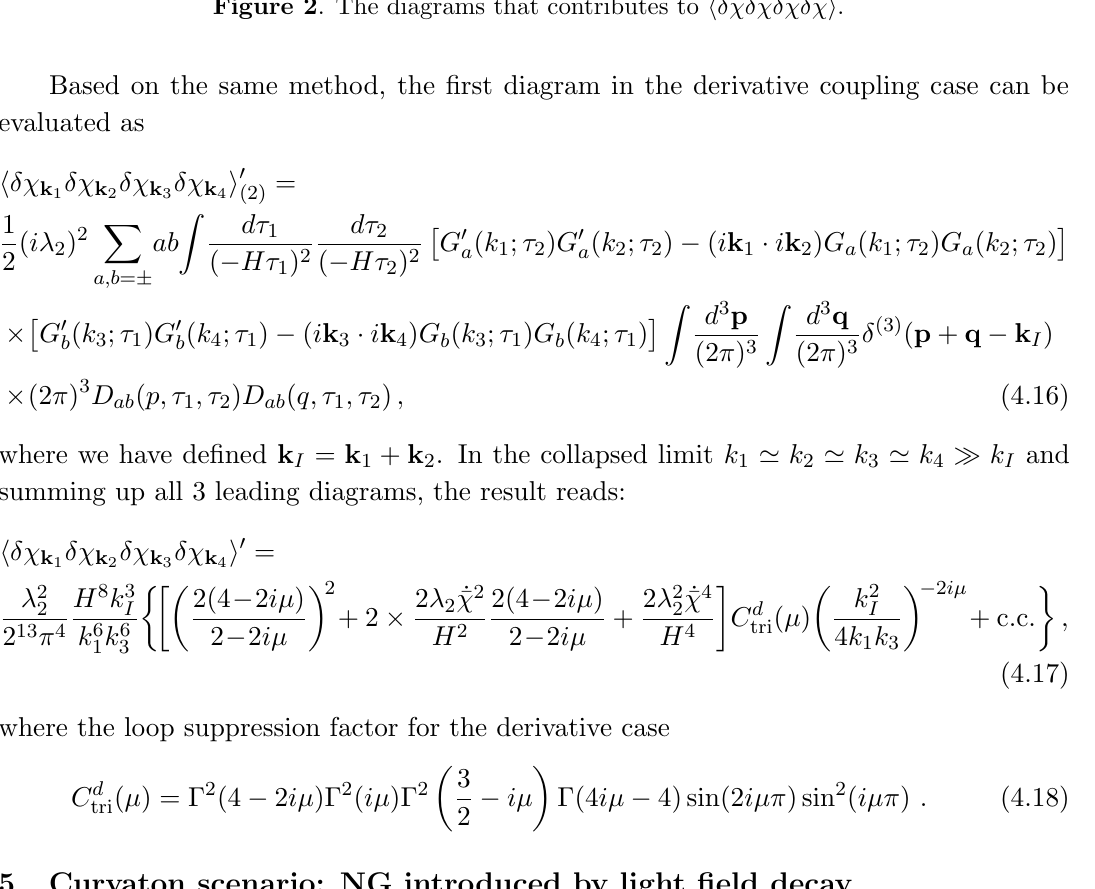
Figure 2 . The diagrams that contributes to h (cid:14)(cid:31)(cid:14)(cid:31)(cid:14)(cid:31)(cid:14)(cid:31) i